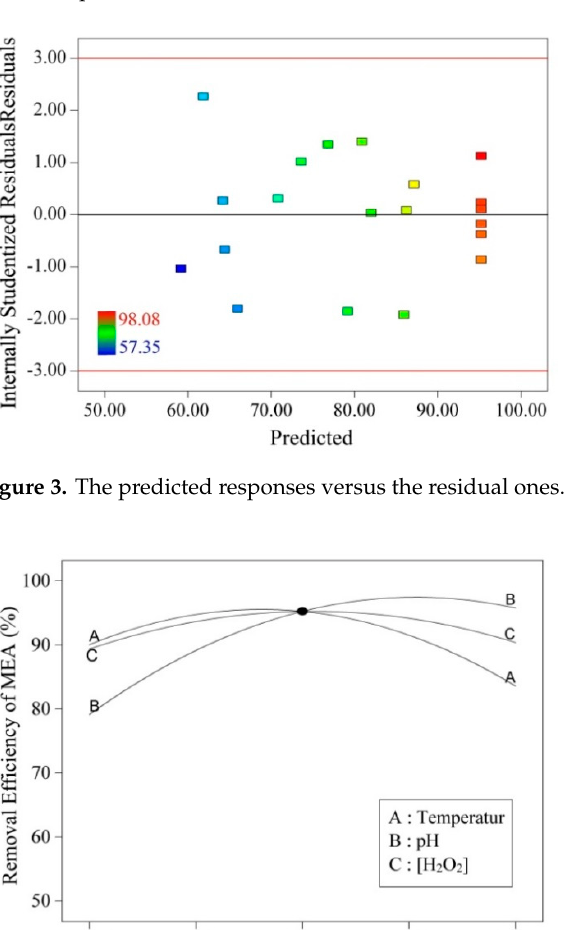
Figure 3. The predicted responses versus the residual ones.